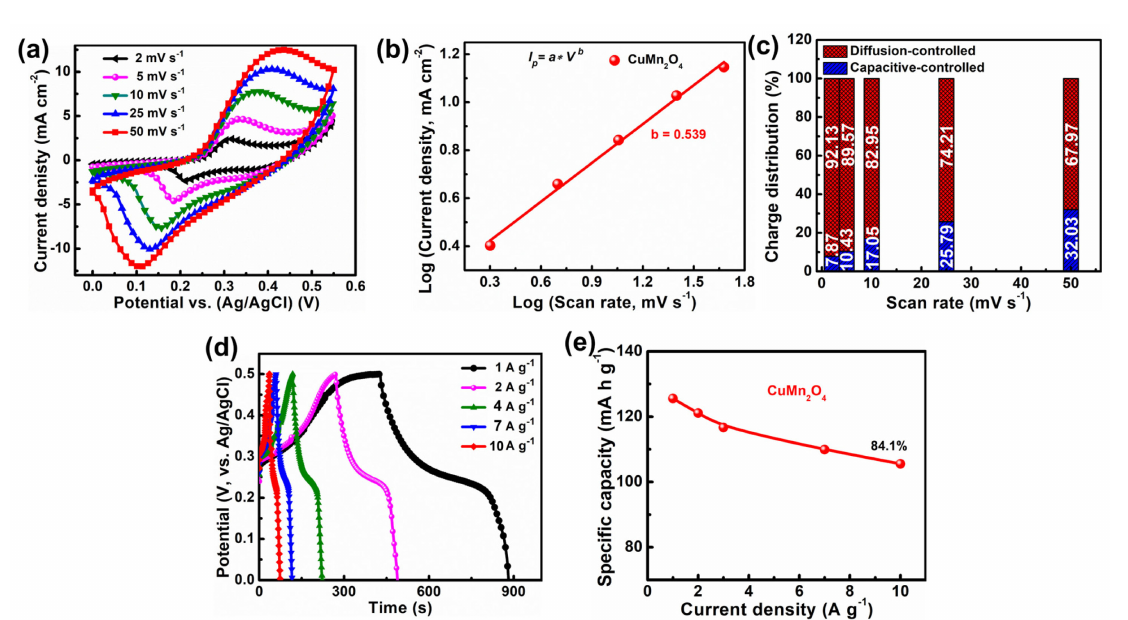
Figure 3. ( a ) CuMn 2 O 4 NSAs electrode CV graphs at different sweep rates. ( b ) The b − value was calculated using a Log of cathodic peak current density vs. a Log of sweep rate. ( c ) The plot of the CuMn 2 O 4 NSAs electrode’s charge distribution vs. scan rates. ( d ) CuMn 2 O 4 NSAs electrode GCD profiles at varied current densities. ( e ) Calculated specific capacity values vs. current density of the CuMn 2 O 4 NSAs